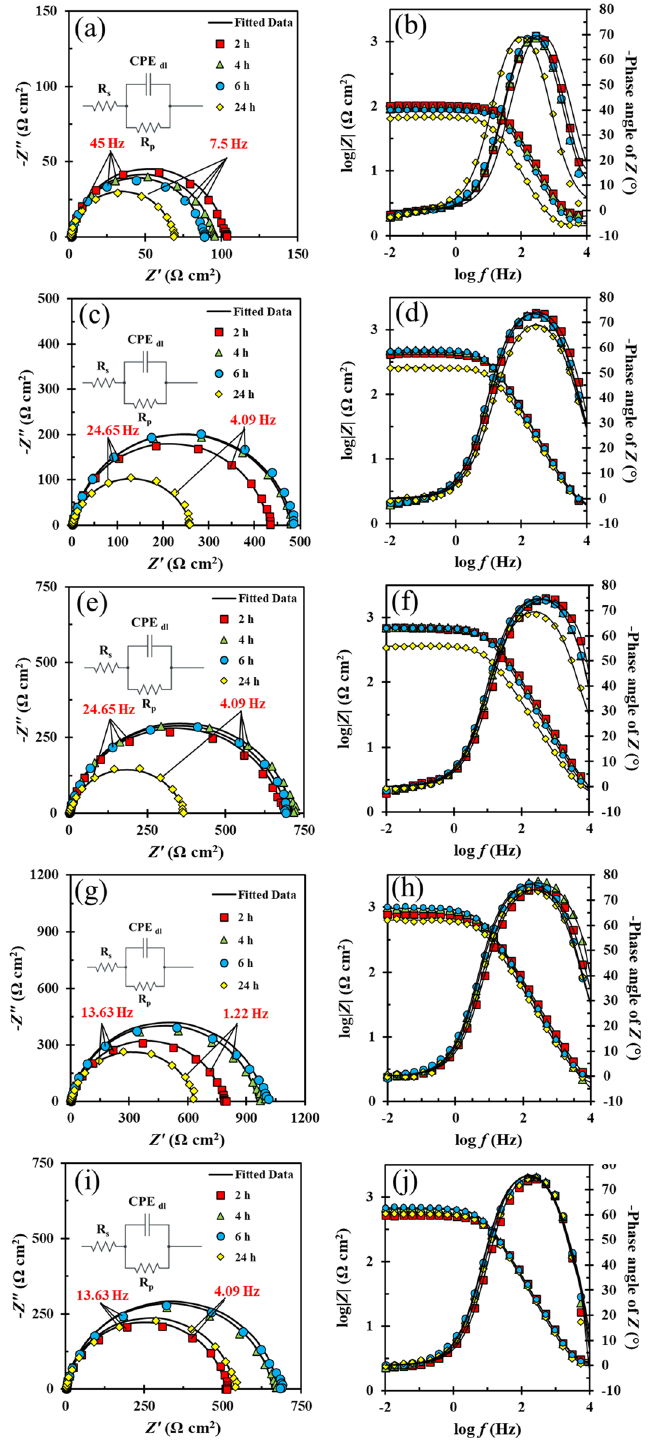
Figure 3. Nyquist (left) and Bode (right) plots of MS soaked in 1 M HCl solution without ( a,b ) and containing 400 ( c,d ), 600 ( e,f ), 800 ( g,h ), and 1000 ( i,j ) ppm of FV